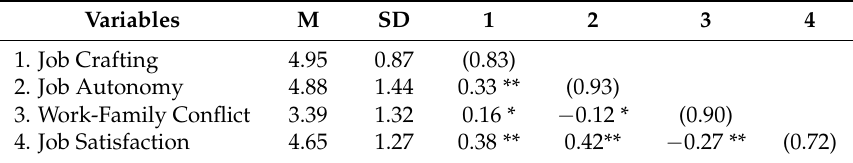
Table 2. Means, Standard Deviations and Correlations—Pearson’s r .